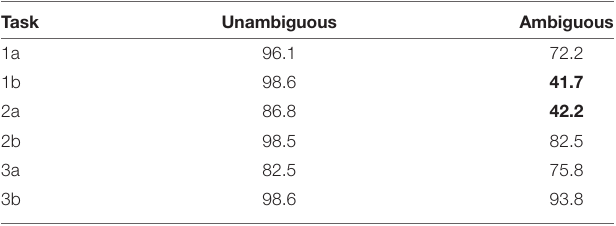
TABLE 4 | Worker accuracy [%] on ambiguous vs unambiguous categories with baseline